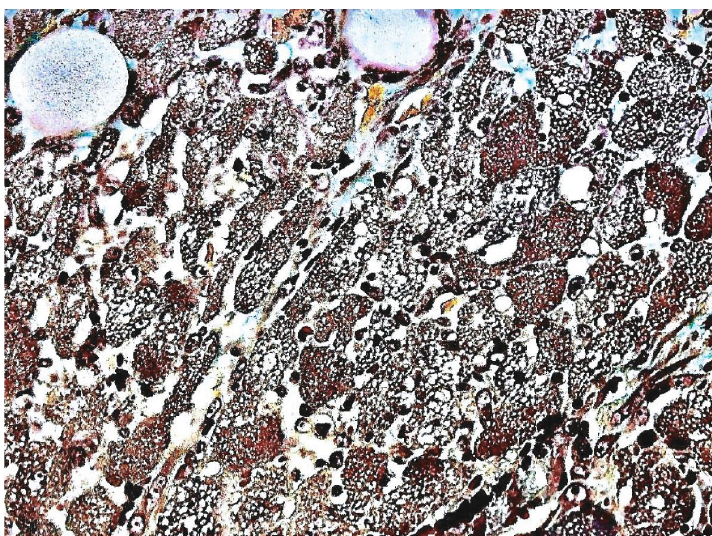
Figure 36: Myocardium in segmental arterial mediolysis. The cytoplasm of most myocytes shows alcian blue-negative vacuoles (hydropic mitochondria). Disruption of the vacuolar membranes has caused the coalescence of their contents fi lling the cells with minute lakes of water similar to smooth muscle in SAM (Figure 3). Edematous fl uid derived from disrupted myocytes containing alcian blue matrix material stemming from the early reparative granulation tissue is evident in the interstitial tissue separating the degenerating myocytes. Movat stain × 200 (adapted from EC Cardiology 5.7 2018, online publication).